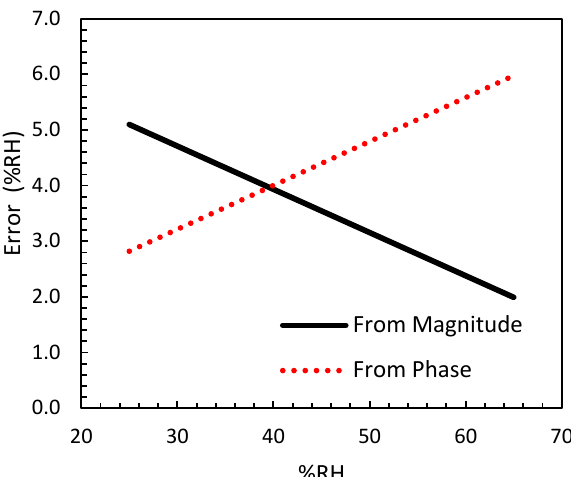
Figure 6. Error of relative humidity at 200 Hz due to the manufacturing variability. The errors were obtained from the magnitude and phase impedance measurement of the sensor.